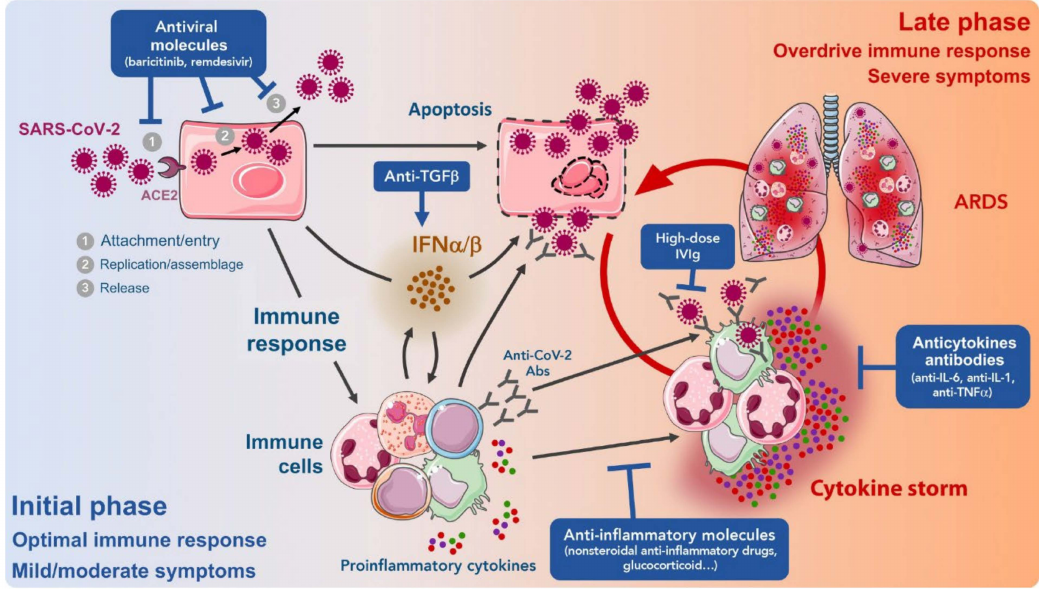
Figure 11. A model of COVID-19-induced infection and possible effective treatments based on enhanced immune response. After SARS-CoV-2 enters the lungs, epithelial cells induce a weak interferon (IFN) α / β production in the initial phase of infection. Hence a limited antiviral immune response is generated which leads to apoptosis of infected cells. This causes the production of pro-inflammatory molecules and the call of immune cells. Using antiviral drugs as a supplement to immunomodulator therapies can reduce the viral load. Reproduced with permission from [231]. Copyright Cell Press,